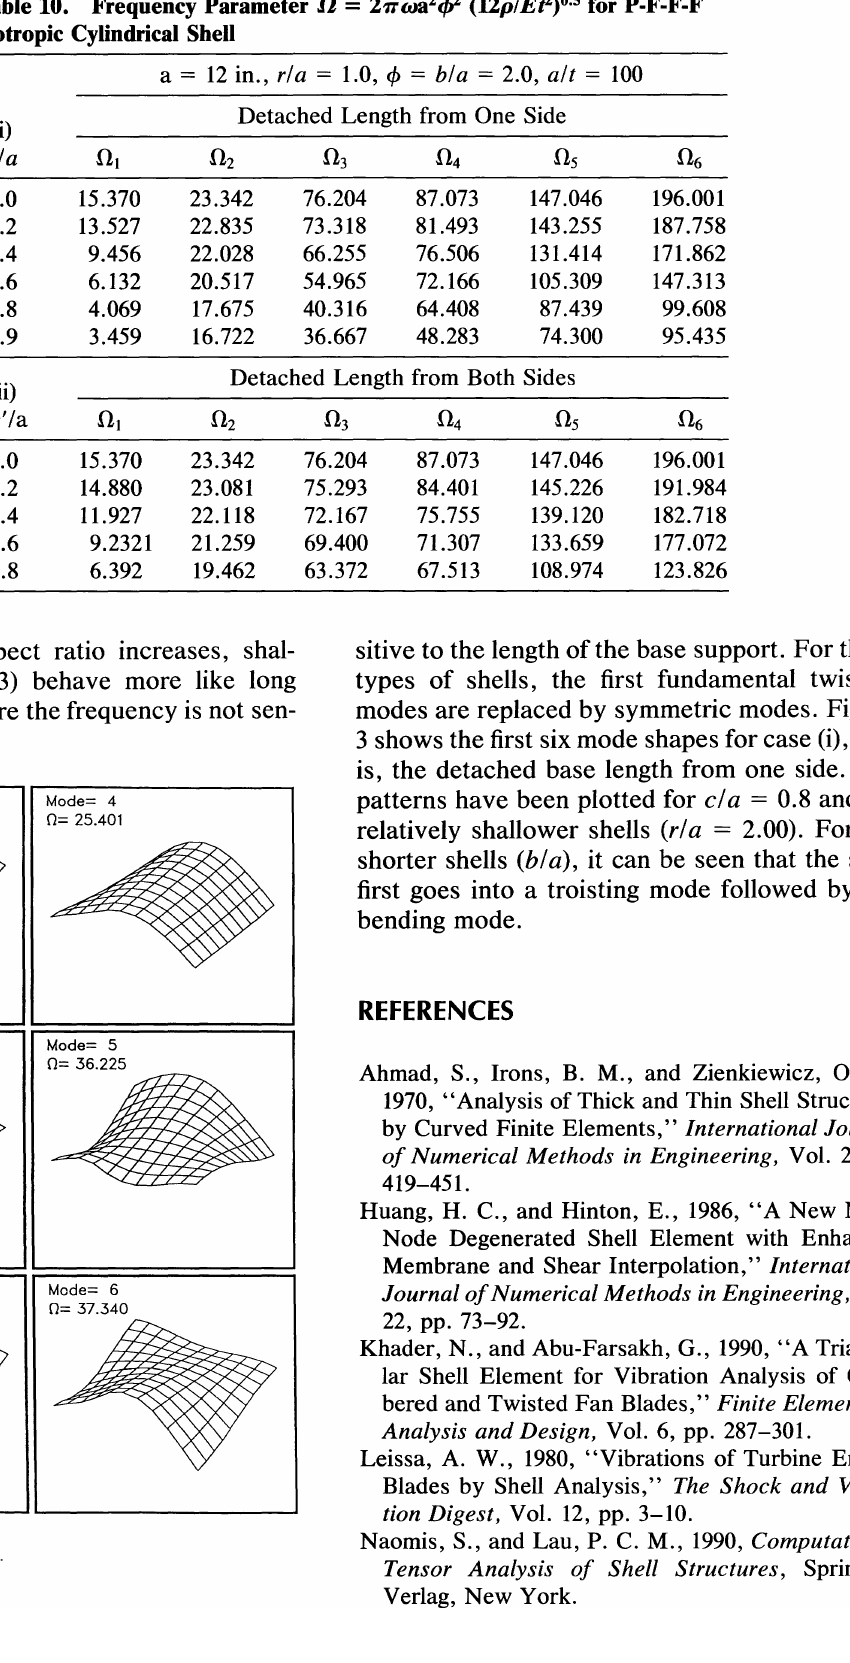
n = 21Twa 2 qr (12pIEP)o.5 for P-F-F-F